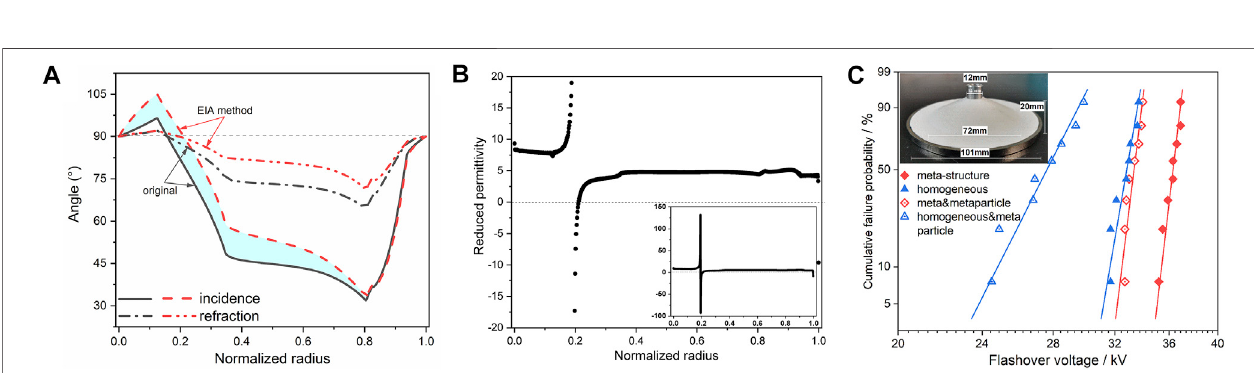
FIGURE 8 | Effect of meta-structure surface on electric fi eld and fl ashover voltage: (A) incidence and refraction angles (relative to the normal direction) along the concave interface, (B) reduced permittivity of the interface dielectric tensor, and (C) Weibull plot of the fl ashover voltage of the basin insulators.